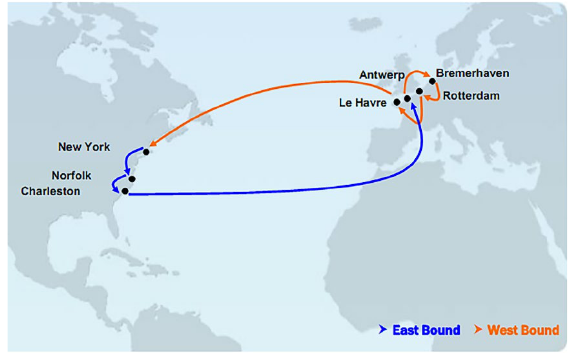
Figure 2. Simple ETE service (Hanjin Shipping 2016)